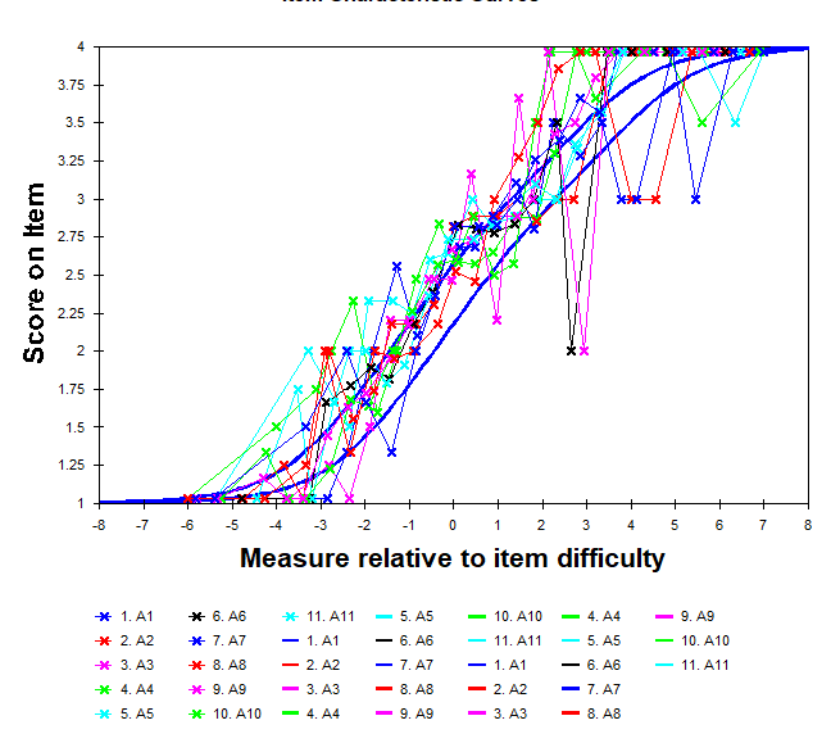
Figure 2 Item Characteristic Curves based on Score